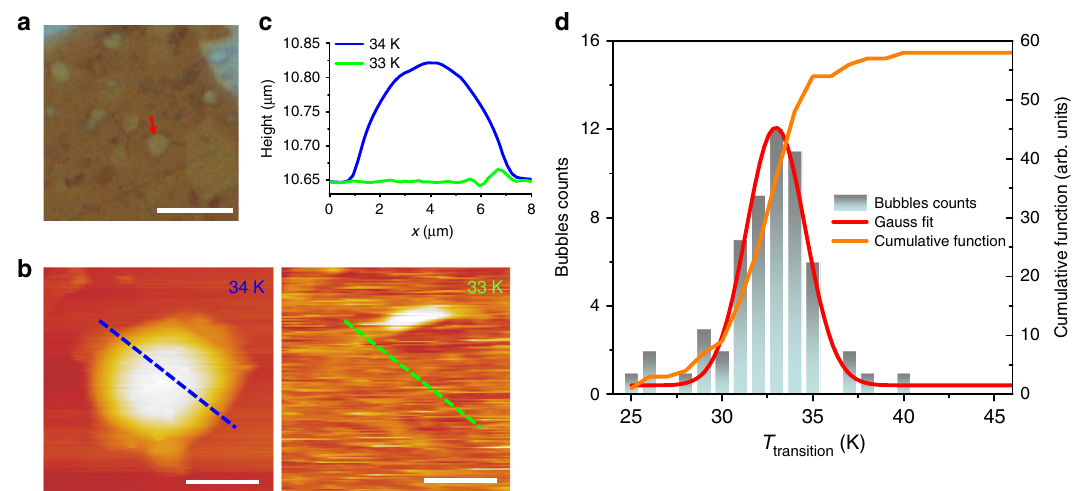
Fig. 4 Swelling and de fl ating processes of the h -BN bubbles containing hydrogen. a An optical image of bubbles on an h -BN fl ake, taken under ambient condition, scale bar: 20 μ m. b Topographic AFM image of a bubble pointed-out by an arrow in ( a ) was measured at 34 and 33 K respectively, scale bars: 3 μ m. c The height pro fi les of line-scan at the same place (indicated by dashed lines in ( b )) where the bubble remains at ~34 K and disappears at ~33 K. d Histogram of the transition temperature ( T transition ) at which bubbles collapse. The red line is a Gaussian fi t to the data. The yellow line is the histogram cumulative function (right